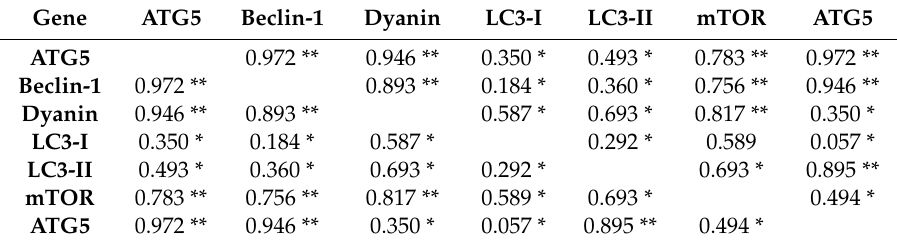
Table 6. Correlation analysis of autophagy-related-genes in the heart of chicken.